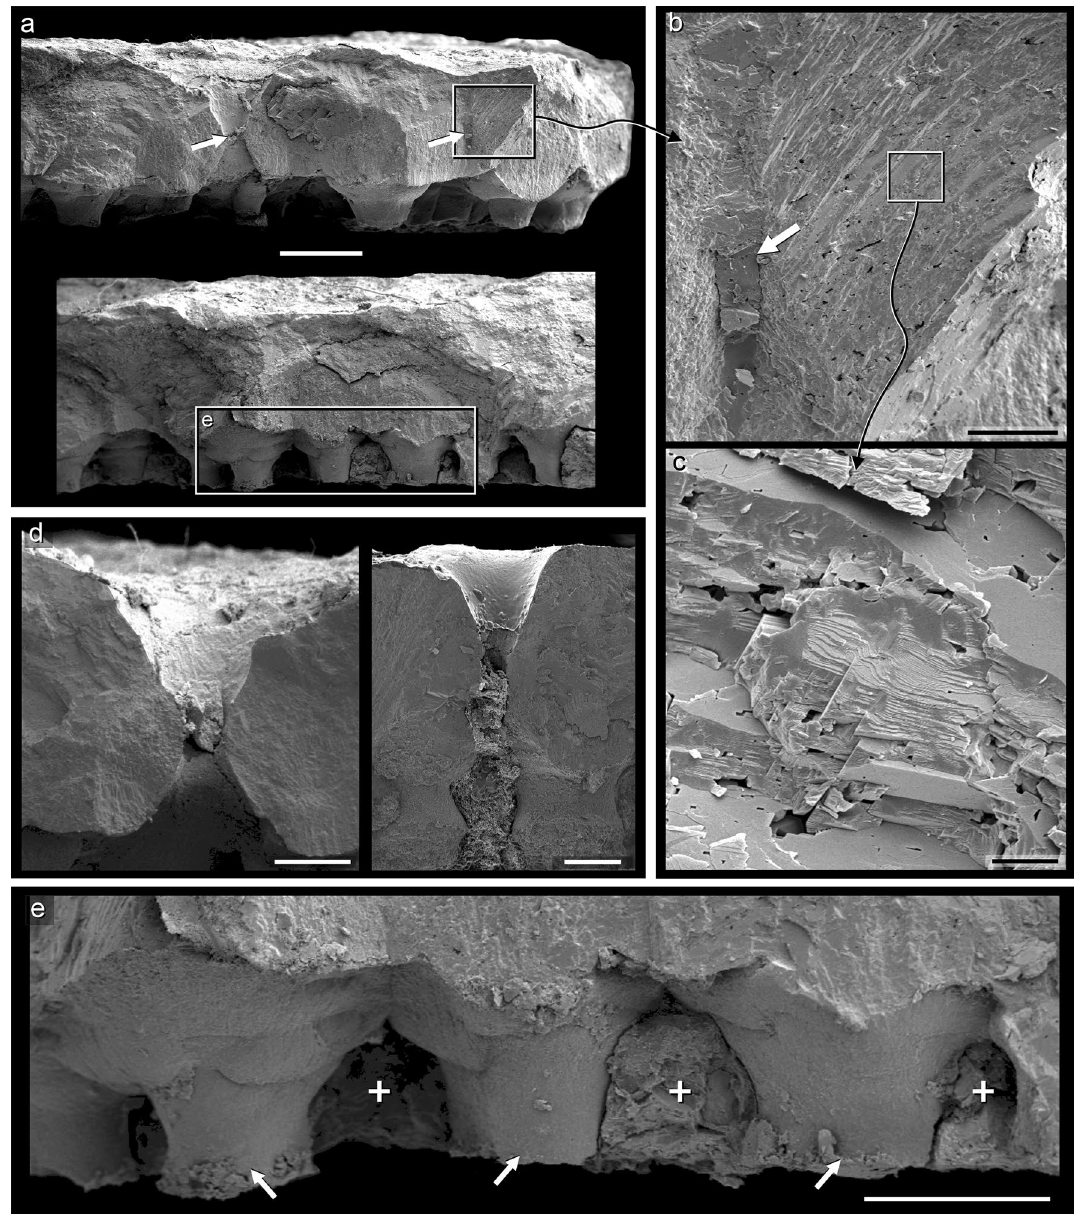
Figure 5. SEM images of eggshells from the Ponte Alta nesting site (taken from the clutch CPPLIP 1798). ( a ) Radial sections of pristine eggshells with some weathering outer (pore canal indicated by white arrows). ( b ) Eggshell growth of lines showing the pristine calcite of the unit with the infilling of the pore channel (white arrow) by secondary calcite deposits. ( c ) Original rhombohedric acicular calcite crystals forming and structuring the unit. ( d ) Very characteristic double funnel-shaped wide pores. ( e ) Well-developed base of eggshell units like “football boot studs” (white arrows) and the particularly evident network of horizontal pore canals running in between (white crosses). Scale bars represent 500 µm ( a ); 100 µm ( b ); 10 µm ( c ); 200 µm ( d , e